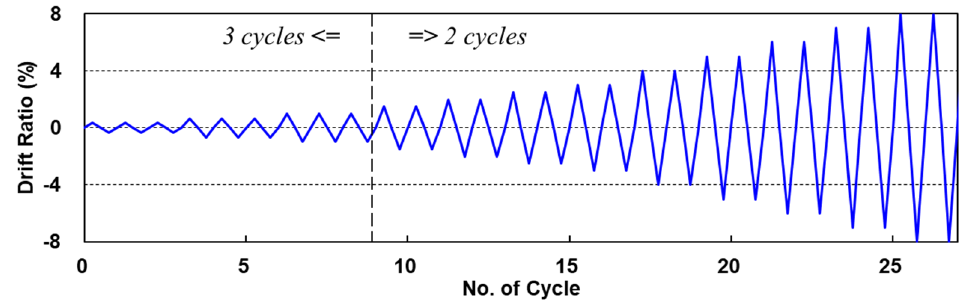
Figure 8. Loading history.